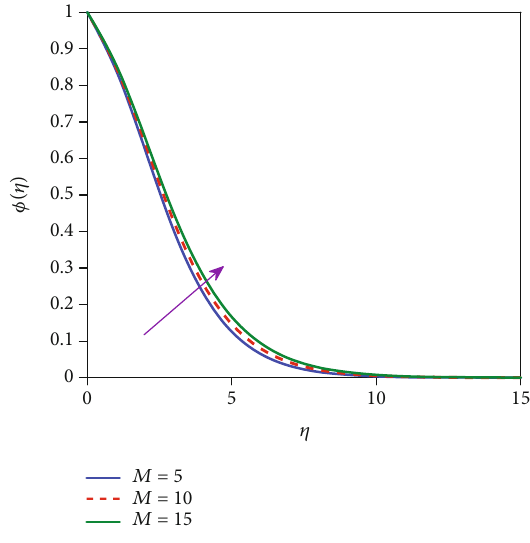
Figure 9: E ff ect of M on the concentration ϕ ð η Þ .